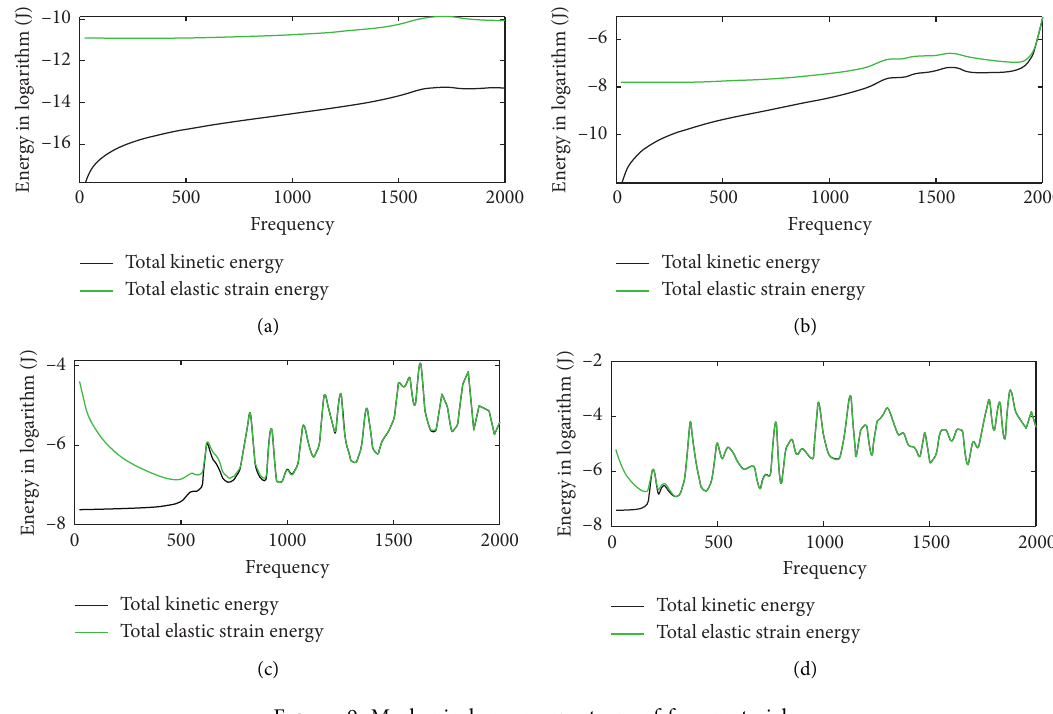
Figure 9: Mechanical energy spectrum of four